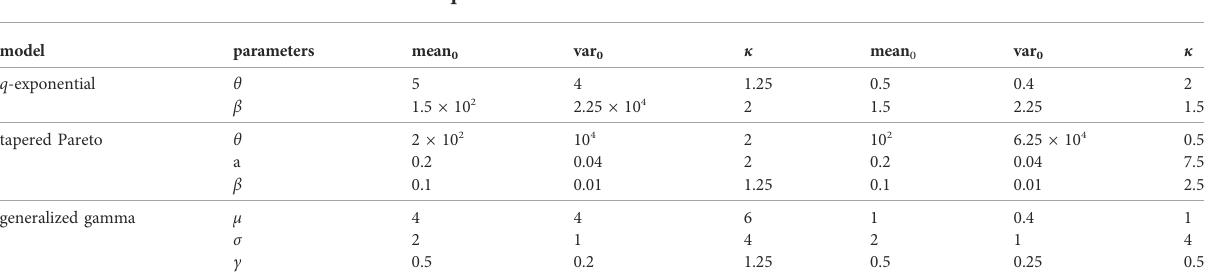
TABLE 1 Parameters of the prior distributions and κ coef fi cients used in the proposal distributions in MH